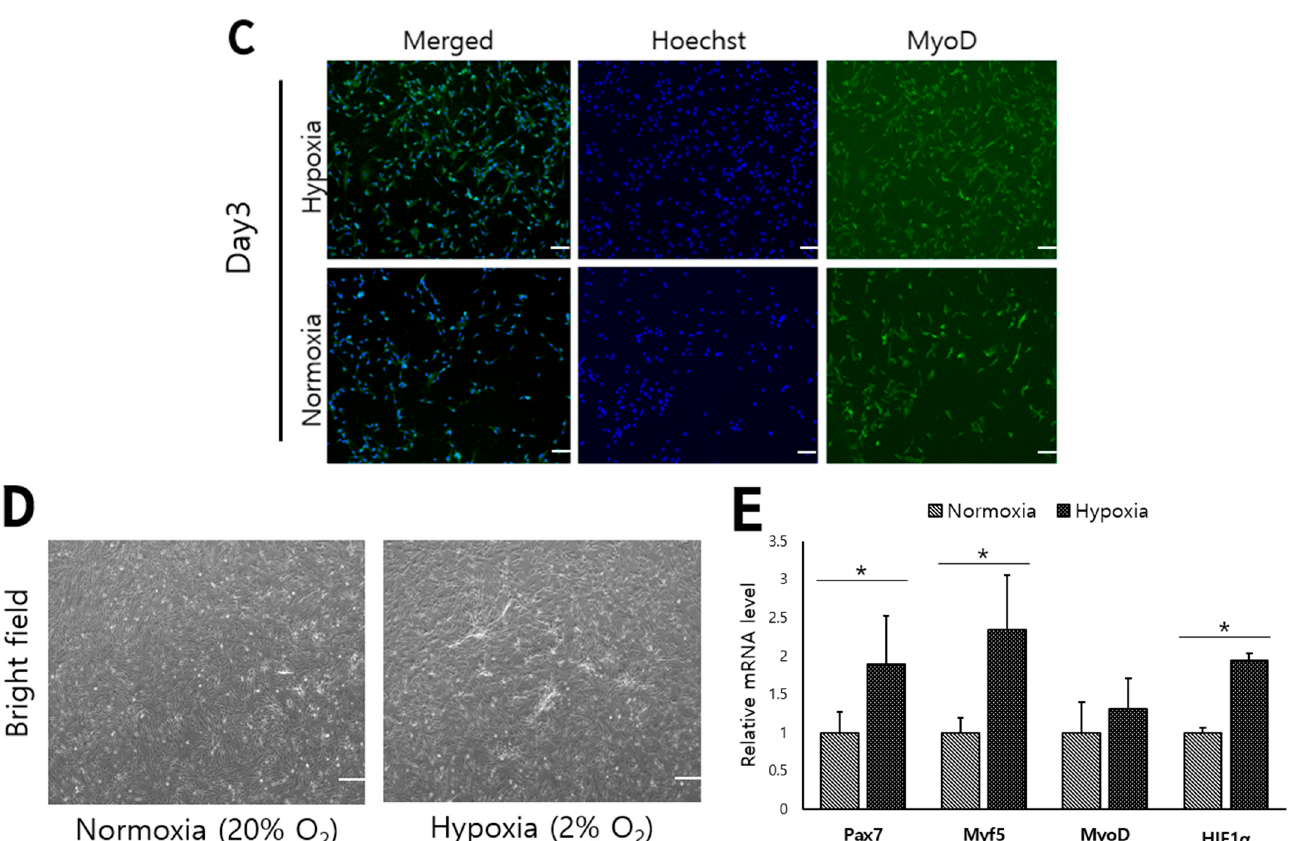
Figure 4. The cell nuclei stained with Hoechst (Hoechst 33,342 nucleic acid stain) were blue fluorescence and Pax7 and MyoD proteins were stained with green fluorescence. ( A ): The nuclei and MyoD protein of Hanwoo myosatellite cells cultured for 1 day in hypoxia (2% O 2 ) and normoxia (20% O 2 ) were stained. ( B , C ): The nuclei, Pax7 and MyoD protein of Hanwoo myosatellite cells cultured for 3 days in hypoxia (2% O 2 ) and normoxia (20% O 2 ) were stained. Experiments were performed in triplicate and repeated three times (* p < 0.05). Hanwoo myosatellite cells were seeded in T25 flasks at 1800 cells/cm 2 and cultured in GM for 6 days in normoxia (20% O 2 ) or hypoxia (2% O 2 ) ( D ). ( E ): Relative Pax7, Myf5, MyoD and HIF1 α mRNA levels were compared in Hanwoo myosatellite cells from ( D ). GAPDH was used as an internal control for RT-PCR. scale bar: 100 μ m.